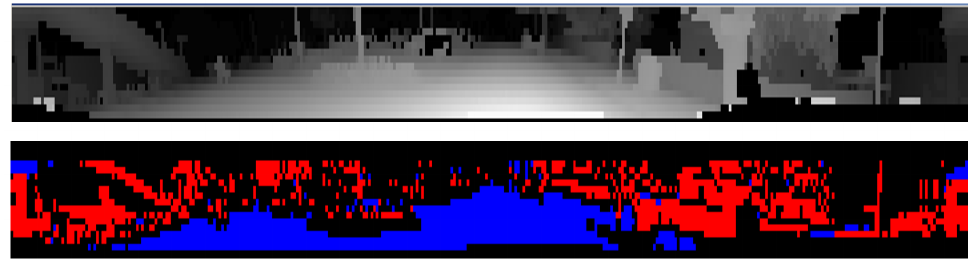
Figure 7. ( Top ): Layer/channel representation of the front left LiDAR output (the logarithm value of the inverse depth is shown for visualization), ( Bottom ): Preliminary classification results (road— blue/obstacles—red).